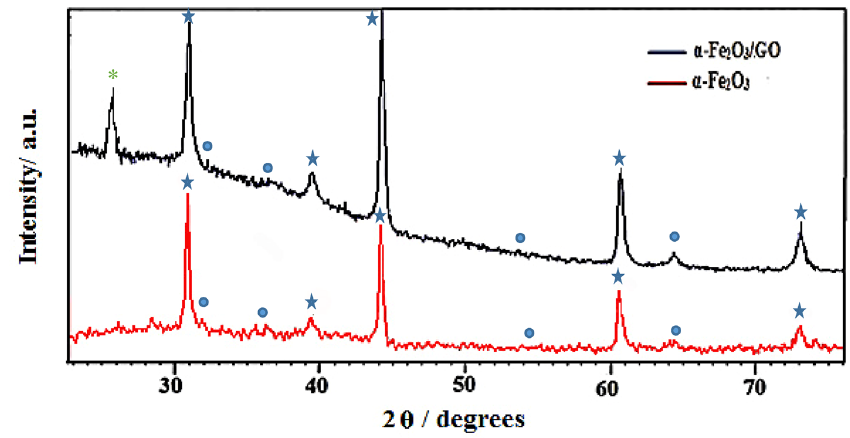
Figure 7. XRD analysis of synthesized thin film